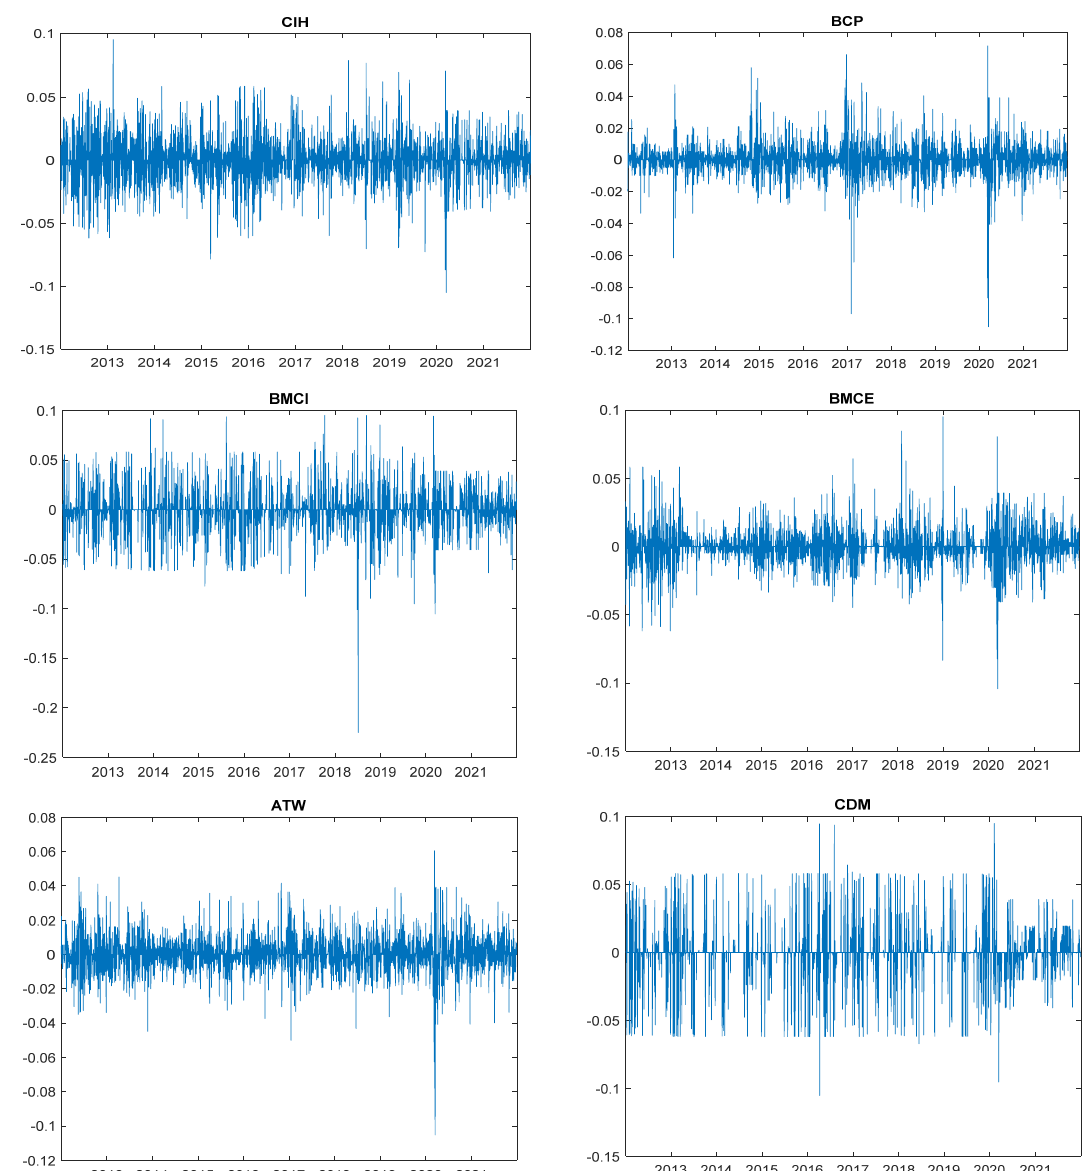
Figure 3. Daily return of the bank index before and during the COVID-19 crisis.